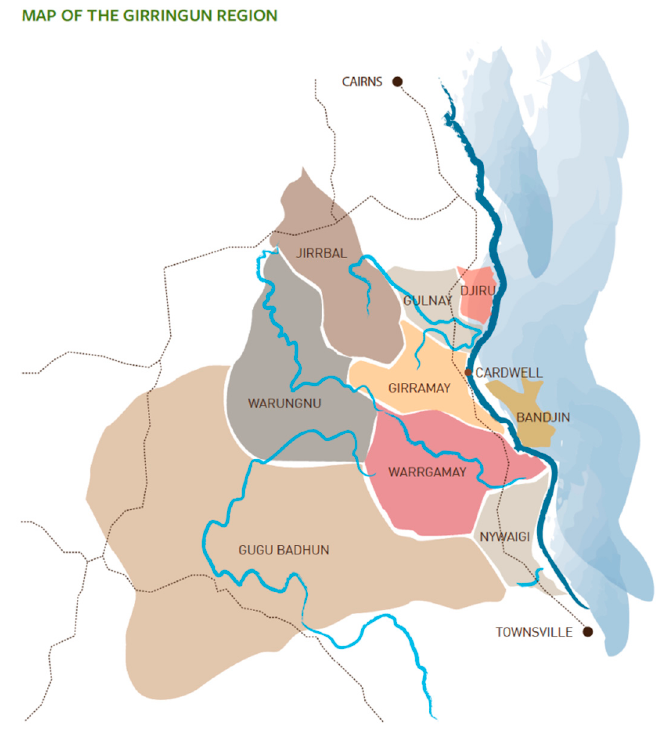
Figure 1. Map of Girringun Traditional Homelands on the north eastern Australian coastline, showing the nine language groups that constitute Girringun’s Traditional Homelands (Reeves and Higgins 2018). Reproduction courtesy of Girringun Aboriginal Art Centre.